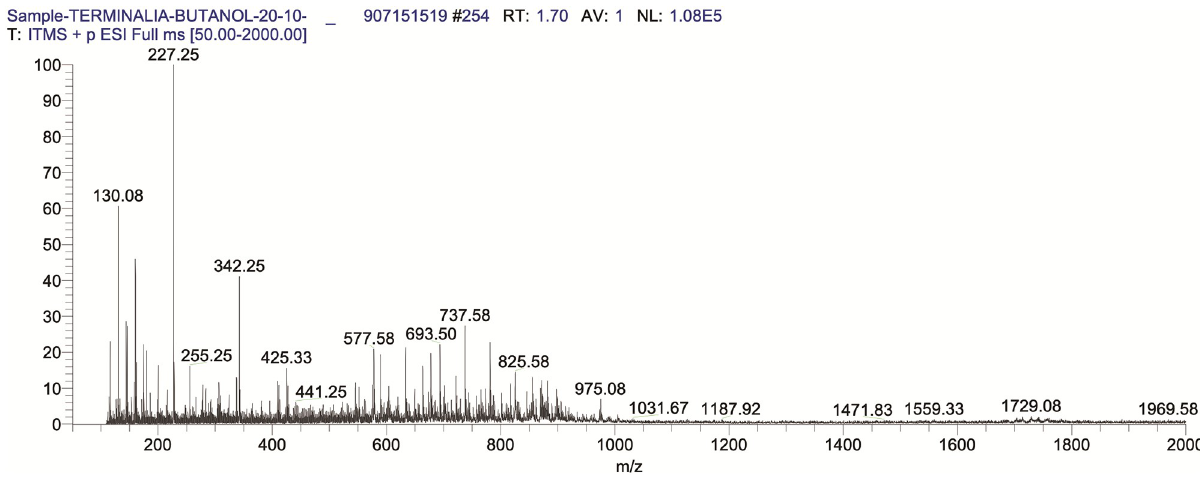
Fig 1. TIC of BUAE in positive ion scan mode.